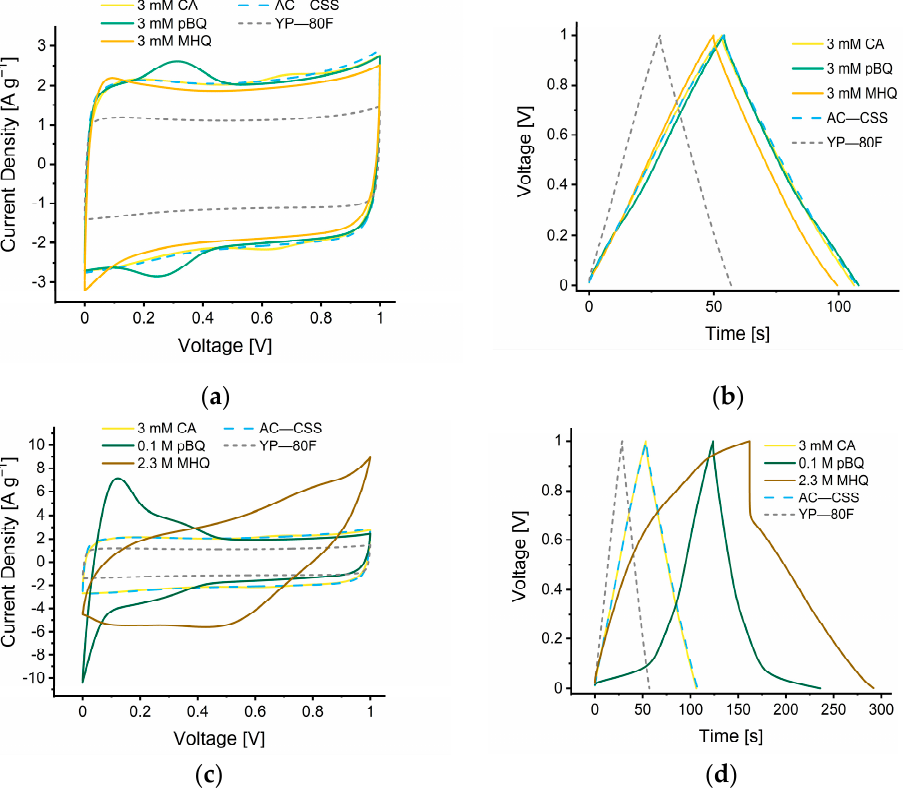
Figure 5. Electrochemical measurements of quinone reinforced supercapacitors compared to their reference (AC—CSS) and the electrode standard (YP—80F). ( a ) Cyclic voltammogram at 20 mV s − 1 , ( b ) galvanostatic charge–discharge curves at 2 A g − 1 with the addition of 3 mM quinones, ( c ) cyclic voltammogram at 20 mV s − 1 , and ( d ) galvanostatic charge–discharge curves at 2 A g − 1 with the addition of quinones at their individual solubility limit. The short dashed grey and dashed blue line indicate the standard electrode YP—80F and the quinone free reference AC—CSS, respectively. The continuous lines show the impact of quinones added to the electrolyte. Due to the fast capacitance decay of SC with 2.3 M MHQ, those curves are representative from the 6th (CV) and 12th (GCD) cycle after test start.